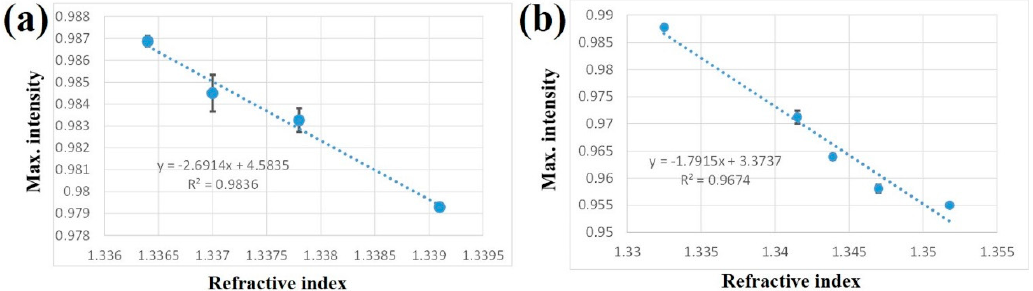
Figure 5. The maximum intensity (peak value) as a function of the refraction index for ( a ) methanol and ( b ) ethanol. The slope in each panel was derived by linearly fitting all data points.